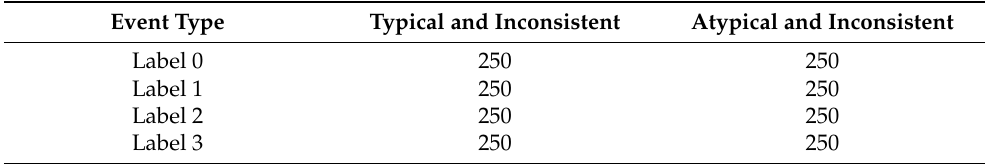
Table 6. Comparison of the recognition results for the five